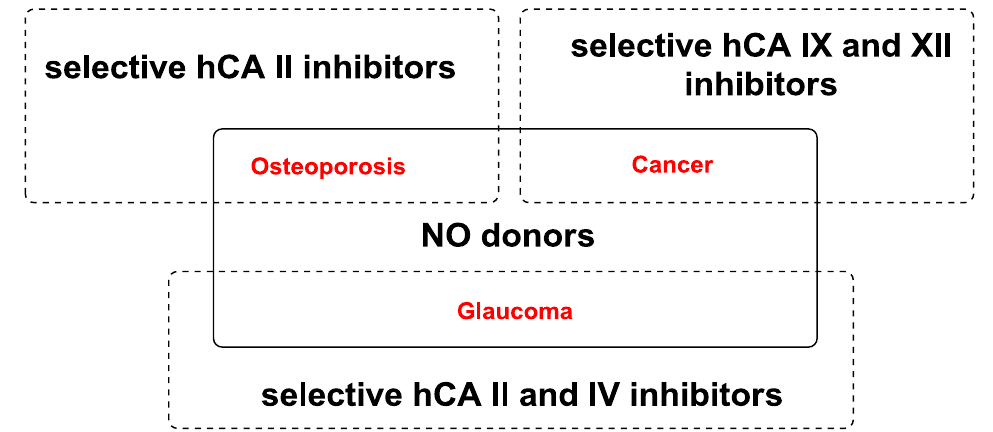
Figure 1. Diseases in which NO-donors and selective hCA inhibitors as dual pharmacological agents are